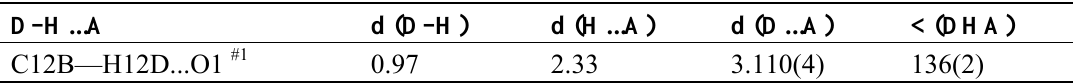
H O Br, [Å and °]. 26 23 4